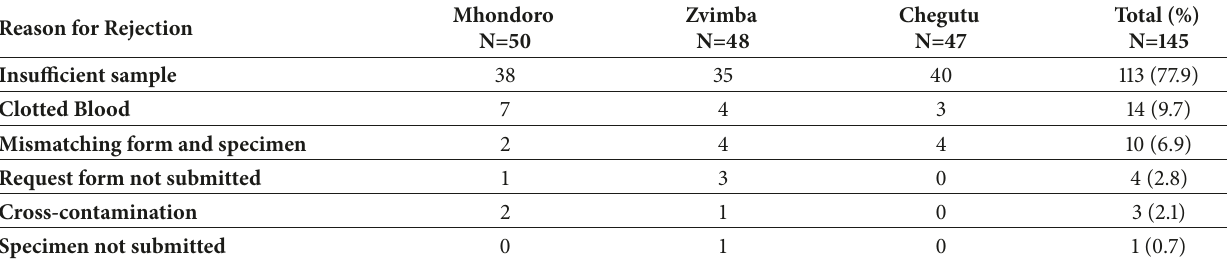
Table 4: Reasons for DBS samples rejections, reported by NMRL for Mhondoro, Zvimba, and Chegutu Districts,